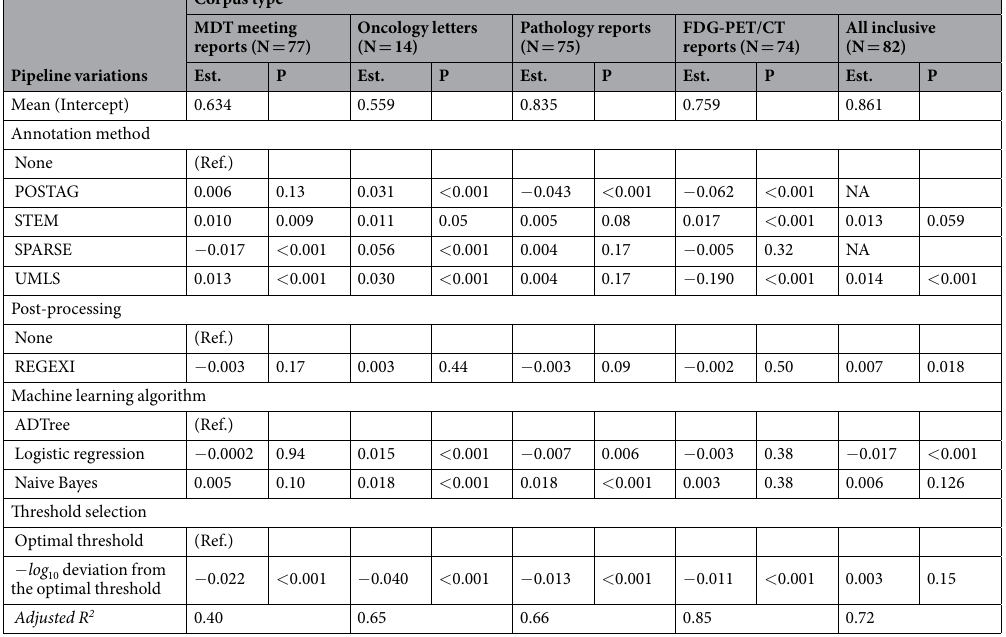
Table 4. Predictive performance by varying methods annotation type, threshold selection, and machine learning methods. NB: Abbreviations: ADTree: Alternating decision tree (10-boosting iterations);